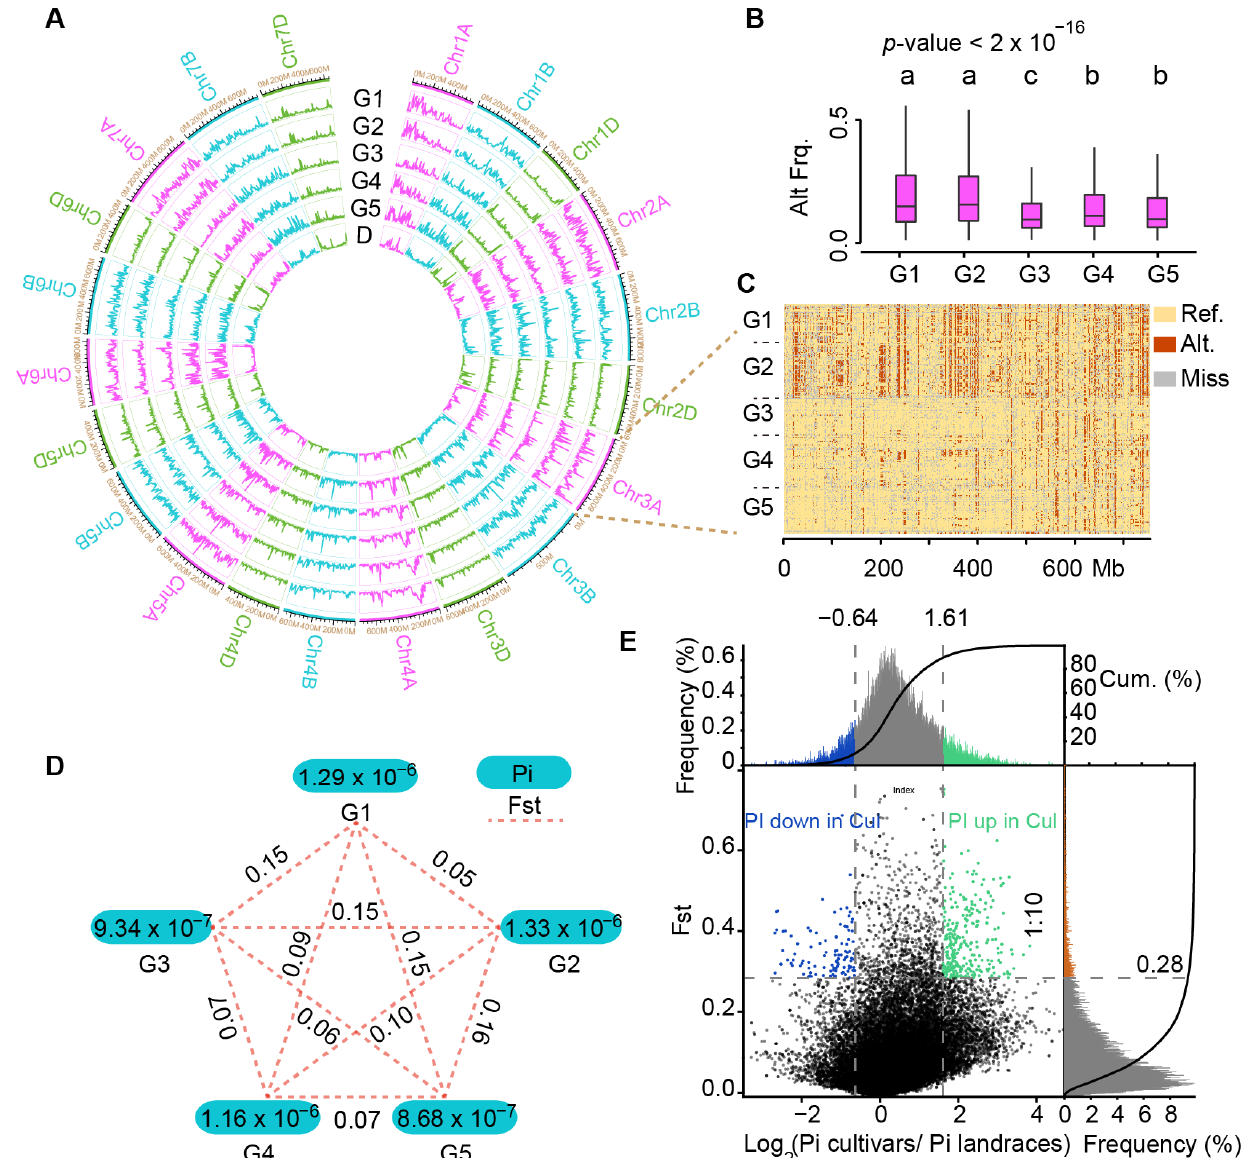
Figure 3. Molecular diversity of the Chinese mini-core collection. ( A ) Circle graph display of alternate allele frequency (G1–G5) and InDel density (D, density) in each sub-group. ( B ) Difference of alternate allele frequency among subgroups. p -value for F statistics in ANOVA was marked in the upper left. The Tukey’s HSD test results were depicted above the violin plot. There were significant differences between groups with different letters ( p -value < 0.05). ( C ) Allele frequency of Chromosome 3A. ( D ) Dissection the molecular diversity of Chinese mini-core collection by subgroups. ( E ) Genomic diversity signatures. The top 10% of Fst and the two-tail top 10% of Pi were used as thresholds to identify distinct diversity segments between cultivars and landraces.